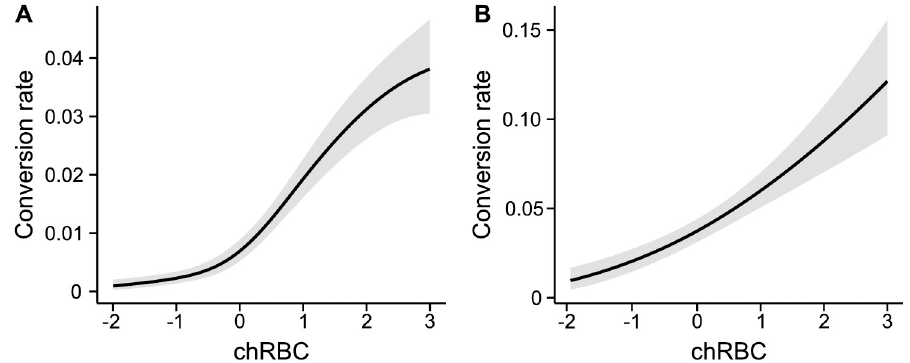
Fig 6. Parasites in good state increase conversion rates as RBC densities increase. RBC density was perturbed independently of parasite state for P . chabaudi parasites exposed to EPO ( A , days 4–14 PI) or phenylhydrazine ( B , day 1 PI). Change in RBC refers to the difference in RBC density between the decision-making and parental cohorts of asexuals. Parasites were in good state during treatments in both experiments, with > 90% exceeding a replication rate of 1.61 ( A ) or 3.3 ( B ). Note, conversion in ( A ) is estimated following [54], while a simpler metric had to be used for ( B ) (see ‘Experiments’ in Materials and methods). Lines and shaded areas are predictions ± SEM from generalised additive models for conversion as a function of changes in RBC